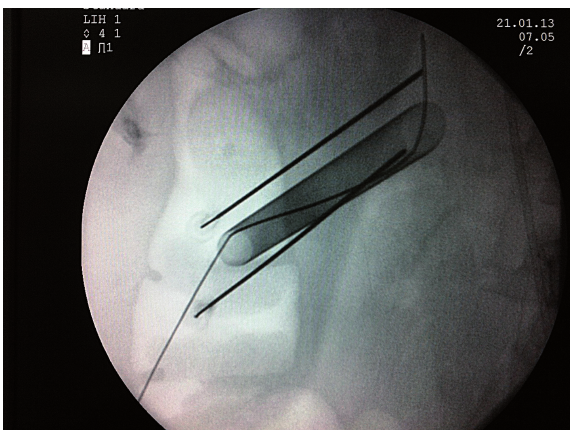
figure 1 - Intraoperative fluoroscopic view of peritubal